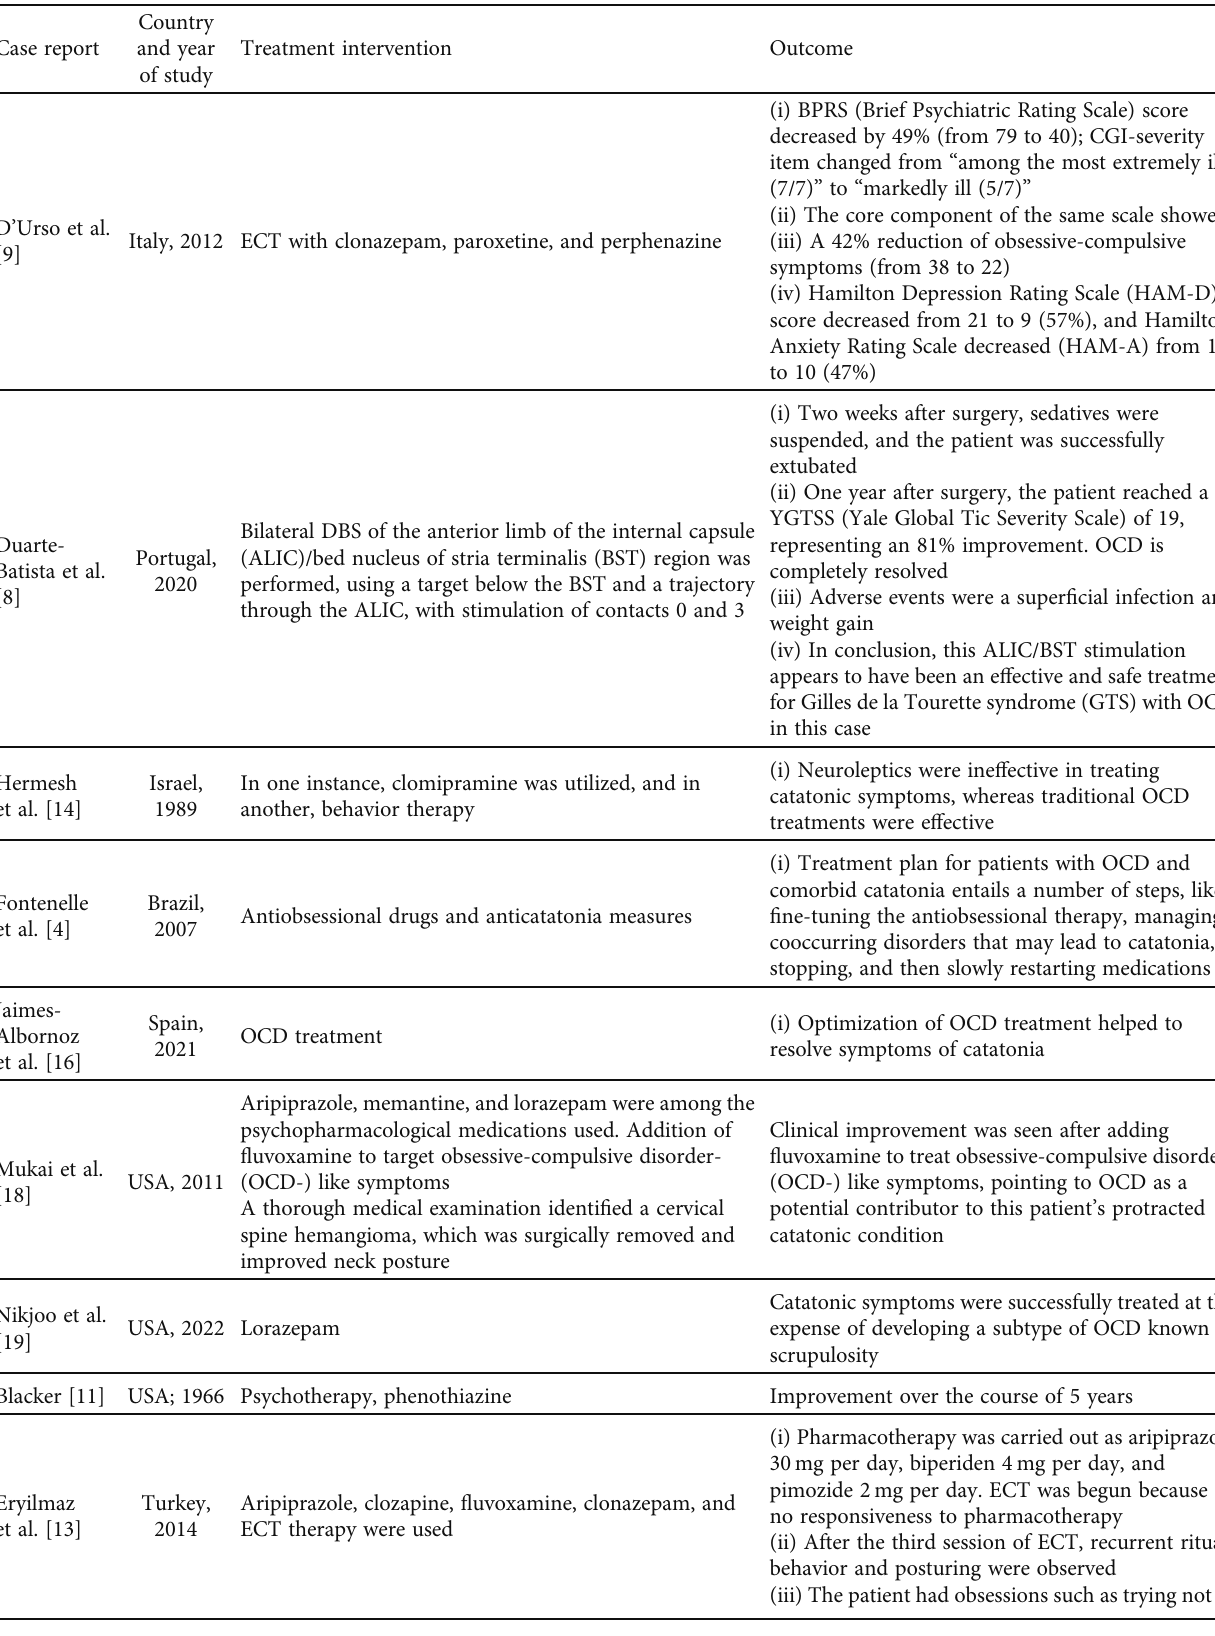
Table 1: The treatment interventions and outcomes of individual